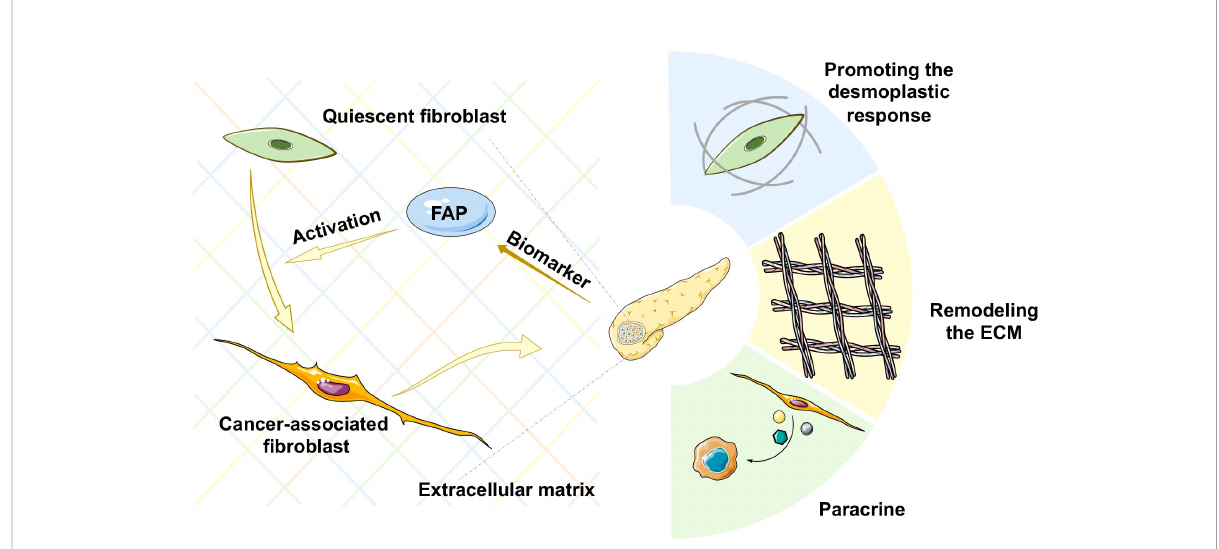
FIGURE 1 Schematic representation of various mechanisms of cancer-associated fi broblast (CAF) activation in pancreatic cancer. ECM, extracellular